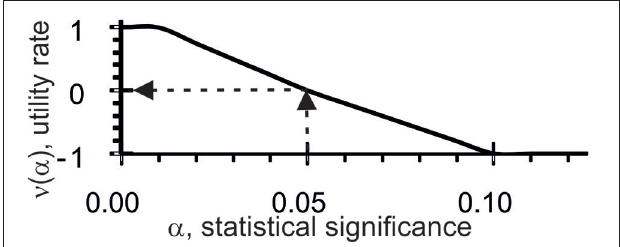
FIGURE 1 | Sample weights (the y -axis), F(i), of tetranucleotide z 1 z 2 z 3 z 4 at the i -th position (the x -axis) of the sequence { ξ i } composed of L nt, with which we assessed the linear additive contribution to X({ ξ i }) using the rule “the higher F(i), the greater the contribution.”